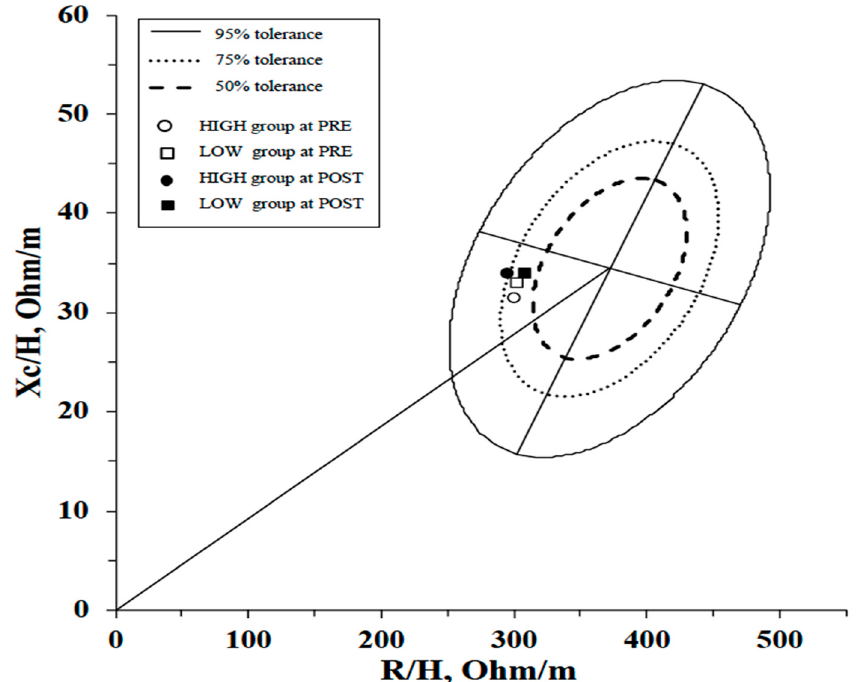
Figure 2. R-Xc graph and vector displacements from before (PRE) to after (POST) the intervention period using the mean R / H and the mean Xc / H plotted on the reference population tolerance ellipses [32]. HIGH: the group with a high-weekly training frequency of three times a week; LOW: the group that performed only one weekly